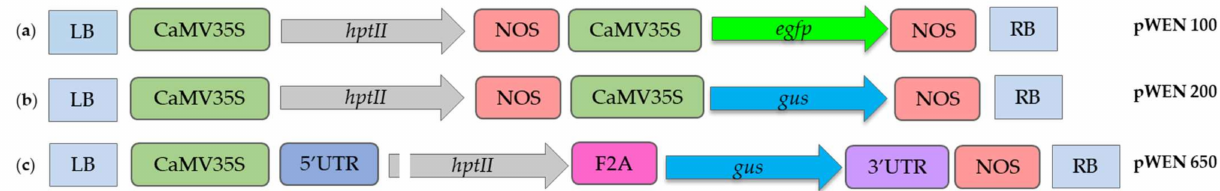
Figure 2. Structure of T-DNA regions of different vector systems. ( a ) The T-DNA fragment of plasmid pWEN 100 harbors the hygromycin-resistant marker gene ( hptII ) and the reporter gene ( egfp ) controlled by CaMV35S promoters. ( b ) The T-DNA region of plasmid pWEN 200 harbors the hptII gene and the reporter gene gus controlled by CaMV35S promoters. ( c ) The T-DNA region of plasmid pWEN 650 harbors the hptII-2A-gus open reading frame (ORF) controlled by the CaMV35S promoter and 5 (cid:48) UTR of the light-harvesting chlorophyll-binding protein of photosystem II (LHCPII) of E. gracilis . A copy of the first intron of LHCPII is placed in the hptII gene keeping the amino acid sequence unchanged. LB: Left border of T-DNA, RB: right border of T-DNA, CaMV35S: cauliflower mosaic virus 35S promoter, hptII : hygromycin phosphotransferase II, NOS: nopaline synthase terminator, egfp : enhanced green fluorescent protein, gus : β -glucuronidase, F2A: foot and mouth disease virus-derived (FMDV)